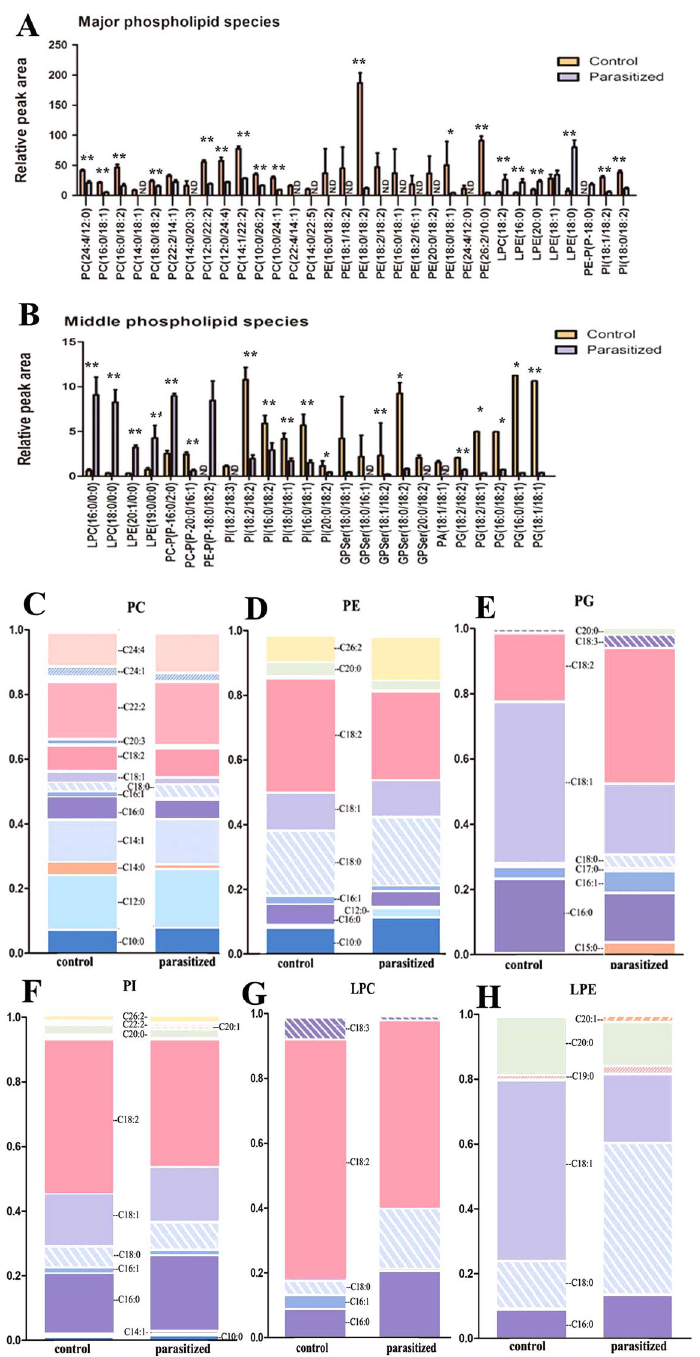
Figure 6. Changes in the lipid composition and fatty acyl chains of phospholipids in parasitized aphids. ( A , B ) Quantification of the relative peak area of major phospholipids ( A ) and middle phospholipids ( B ) in parasitized and control aphids. Data are means ± SEM; n = 6/group. * p < 0.05, ** p < 0.01. N.D, not detected. ( C – H ) Changes in the glycerophospholipid base chemistry and fatty acyl chains in the phospholipids of parasitized and control aphids (PC, C; PE, D; PG, E; PI, F; LPC, G; LPE, H). Data are means ± SEM (n =